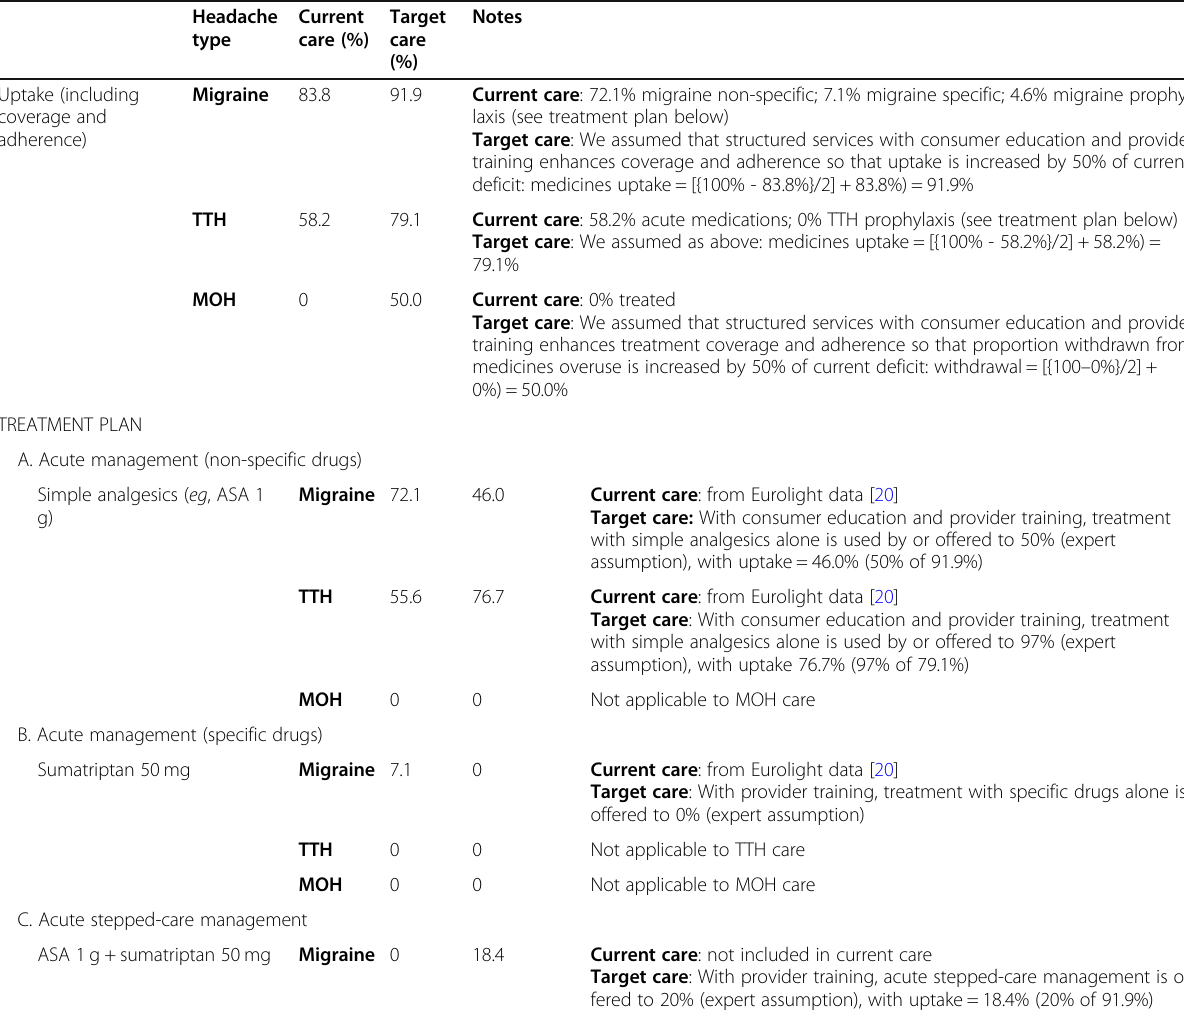
Table 1 Treatment uptake, use of resources and lost productivity according to treatment management plan